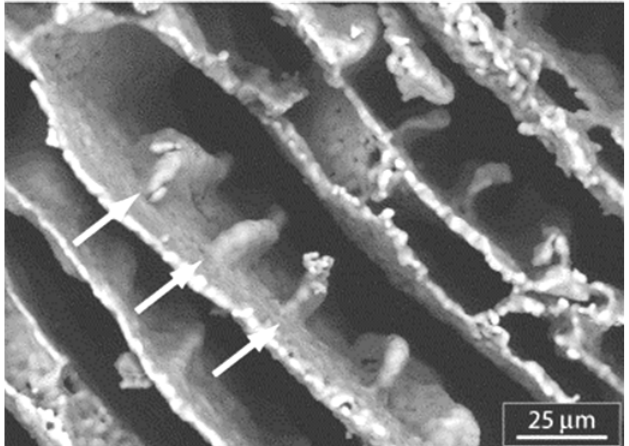
Figure 11. Surface dendrites, oriented along the ice growth direction, cross section perpendicular to ice growth direction. These may guide cell growth as they penetrate the structure. Reproduced from [51] with permission from